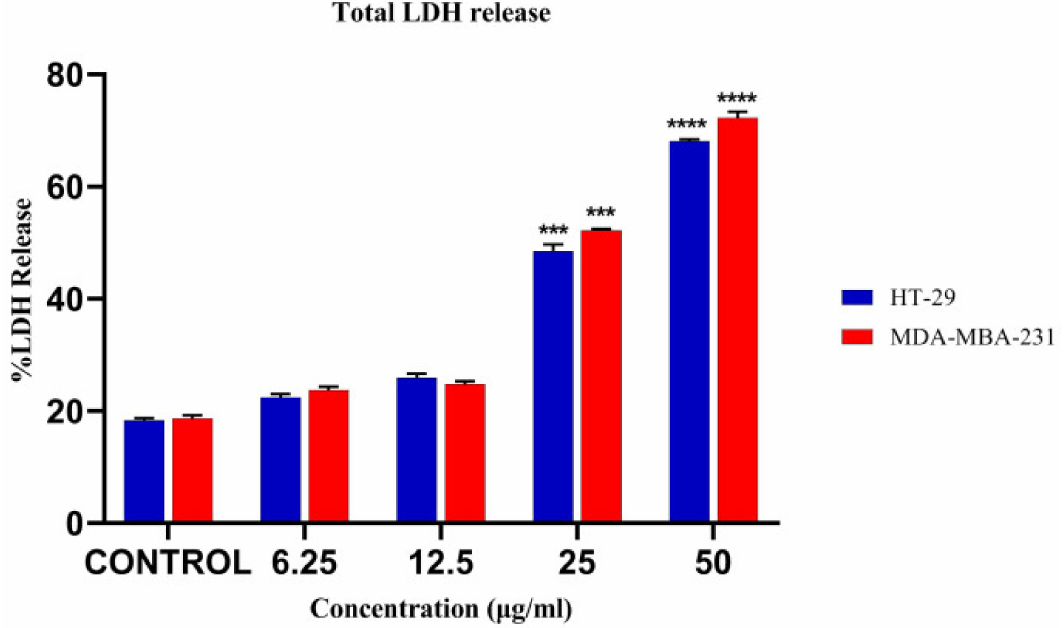
Figure 10. Effects of leptulipin on LDH release from the cancer cells. Maximum release was seen at 50 µ g/mL. N = 3, p < 0.001 (***) and p < 0.0001